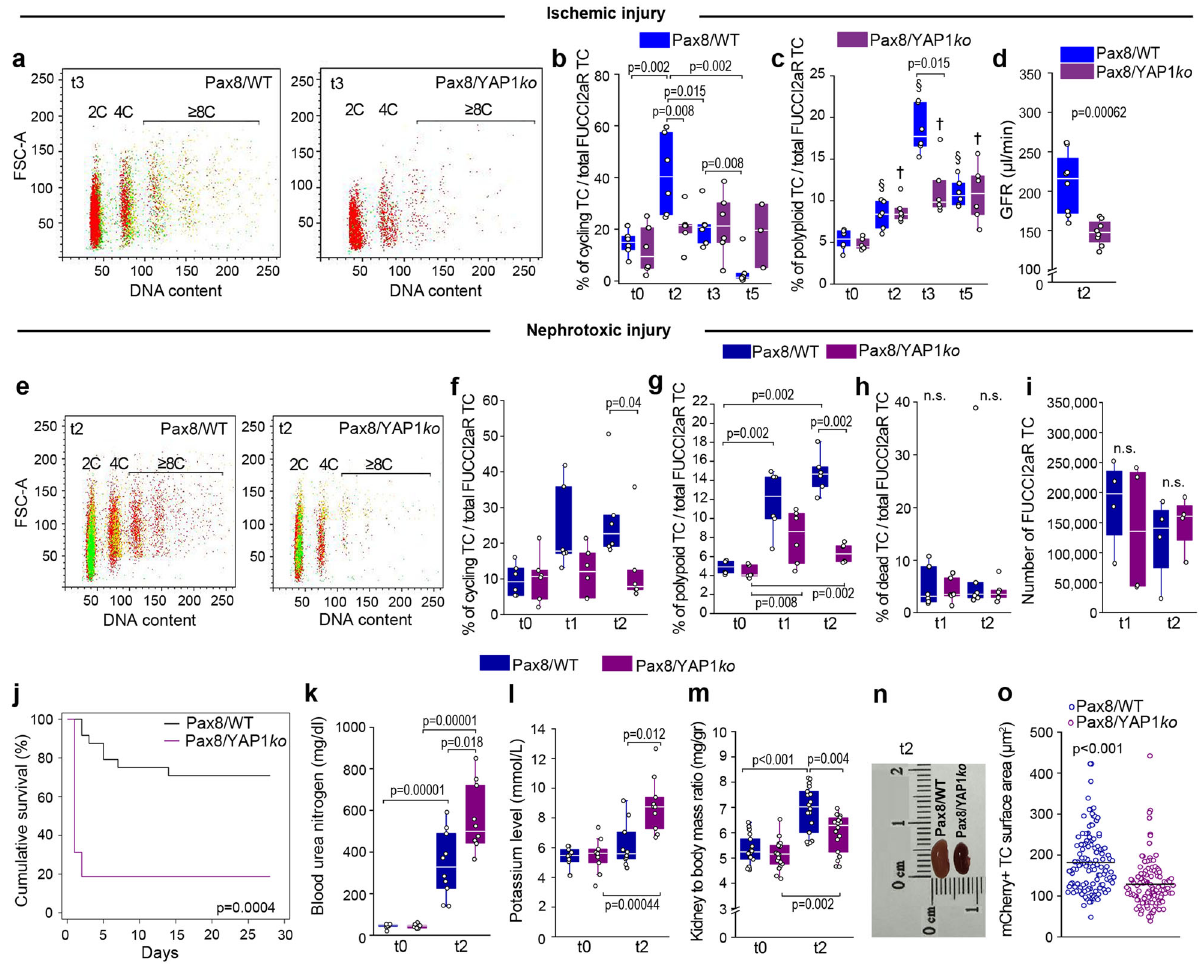
Fig. 5 | Early tubular cell (TC) polyploidization preserves residual kidney functionandassuressurvivalduringAKI.a FACSplotsofPax8/FUCCI2aR(Pax8/ WT) ( n =6) and Pax8/FUCCI2aR/YAP1ko (Pax8/YAP1 ko ) ( n =6) showing diploid (2C), tetraploid (4C) and octaploid or greater ( ≥ 8C) TC. Colours match the